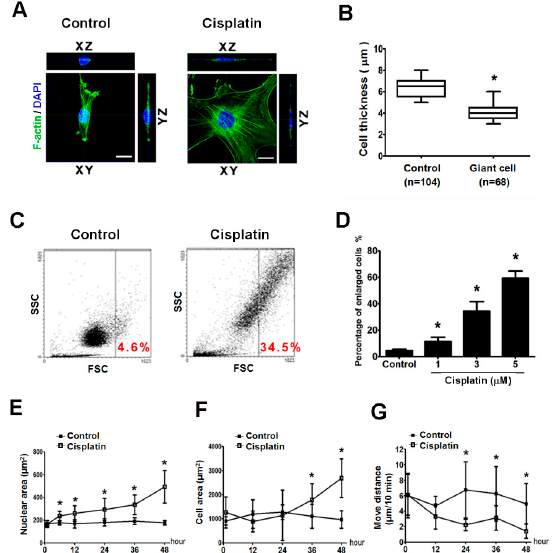
Figure 3. The characteristics of cisplatin-induced giant cells in vitro. B16-F10 cells were treated with 3 µ M cisplatin for 48 h. ( A ) The 3D images were established by XZ and YZ cross sections of cells. Scale bar, 20 µ m. ( B ) The thickness of the melanoma cells was measured by Z-stack confocal microscopy, and the results are presented as a box plot that illustrates the variation in the cellular thickness. * p < 0.05 compared with the control cells. ( C ) The cisplatin-induced enlarged cells were analyzed by flow cytometry. The forward scatter (FSC) represents the cell size (X axis), and the side scatter (SSC) represents the inner complexity of the cell (Y axis). The cell size was gated in the dot plot and defined the cisplatin-induced enlarged cells by the cell size. The percentages of enlarged cells indicated on the panel are the means of three independent experiments. ( D ) The percentages of enlarged cells induced by various doses of cisplatin are assayed by flow cytometry. * p < 0.05 compared with the control cells. ( E , F ) The nuclear and cell surface areas were determined by software. ( G ) The motilities of the cells were measured by the distance that a single cell travelled in 10 min. ( E – G ) * p < 0.05 compared with the control cells.